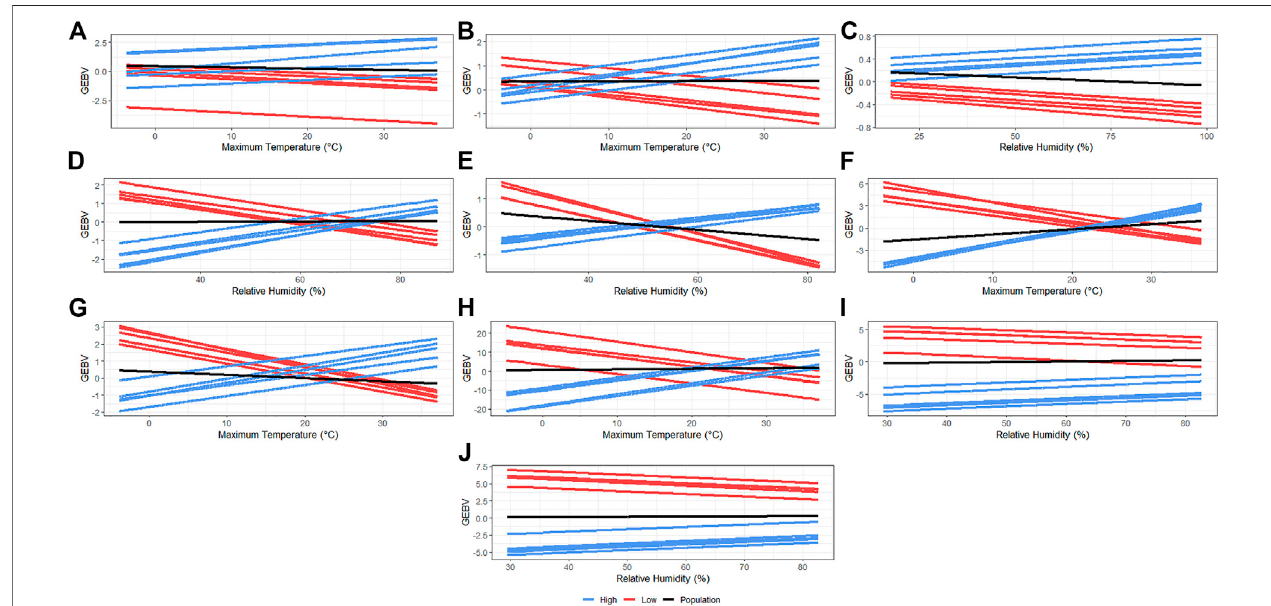
FIGURE2| Genomicestimatedbreedingvaluesforeachrecommendedenvironmentalvariableandcriticalperiodforeachstudiedtraitconsidering fi vemostheat- tolerant and fi ve most heat-susceptible sires. The black line indicates the population trend, the blue lines indicate the most tolerant sires, and the red line indicates the most susceptible sires. (A) Total number of piglets born. (B) Number of piglets born alive. (C) Number of piglets born dead. (D) Number of piglets weaned considering measurement until weaning date. (E) Weaning weight (kg) considering measurement until weaning date. (F) Interval between wean to estrus (days). (G) Interval between farrows (days). (H) Off-test weight (kg) considering an interval of 30 days. (I) Ultrasound muscle depth (mm) considering an interval of 30 days. (J) Ultrasound backfat thickness (mm) considering an interval of 30